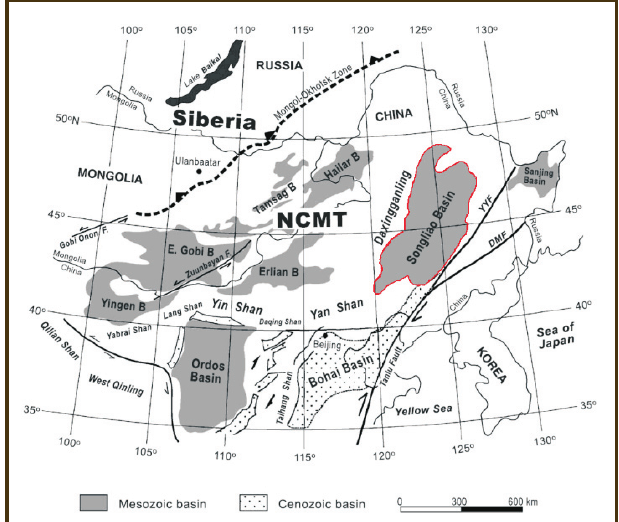
Figure 1. Location of the Songliao Basin in the tectonic framework of the North China–Mongolia Tract (NCMT). The NCMT is separat- ed from the East Siberian Craton by the Mongolia-Okhotsk suture zone and is marked by the Yinshan-Yanshan Belt in the south and by the Daxing-Ganling Belt in the east. YYF=Yilan-Yitong fault; DMF= Dunhua-Mishan fault; HSZ = Honam Shear Zone; B= basin; F =